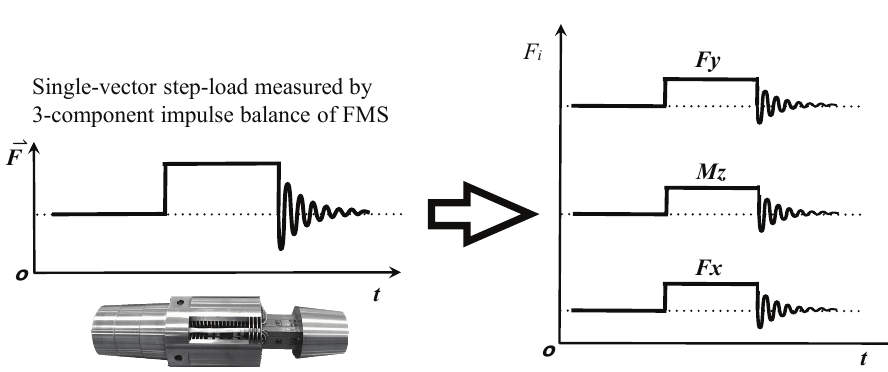
Figure 3. A single-vector load generates three-component step loads measured by the balance of the FMS.